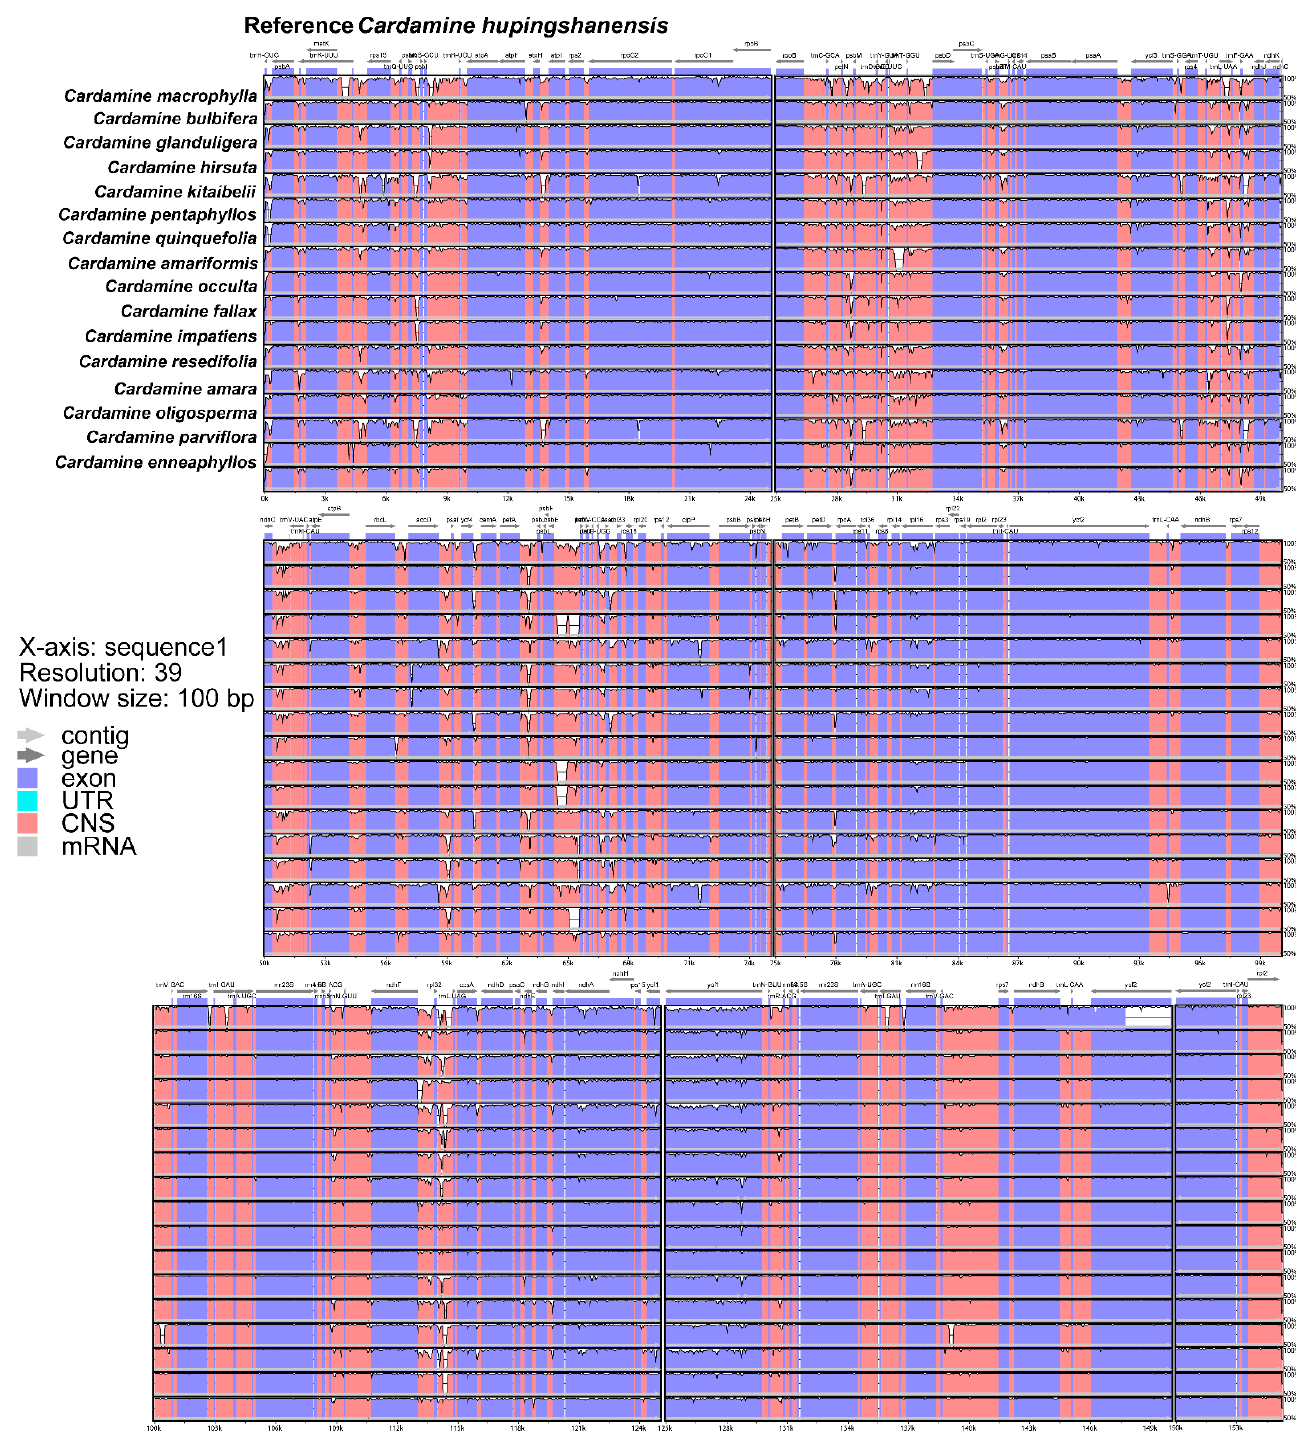
Figure 2. Sequence identity plots of 187 Cardamine species using mVISTA. Sequence variations among 17 Cardamine species using C. hupingshanensis as base reference. Regions in pink indicate conserved non-coding sequences, purple are conserved exons, and white-colored regions identify more variable sites. The Y-axis represents percent identity ranging from 50% to 100%. IR junctions are indicated in parentheses to show LSC, SSC and IR regions.